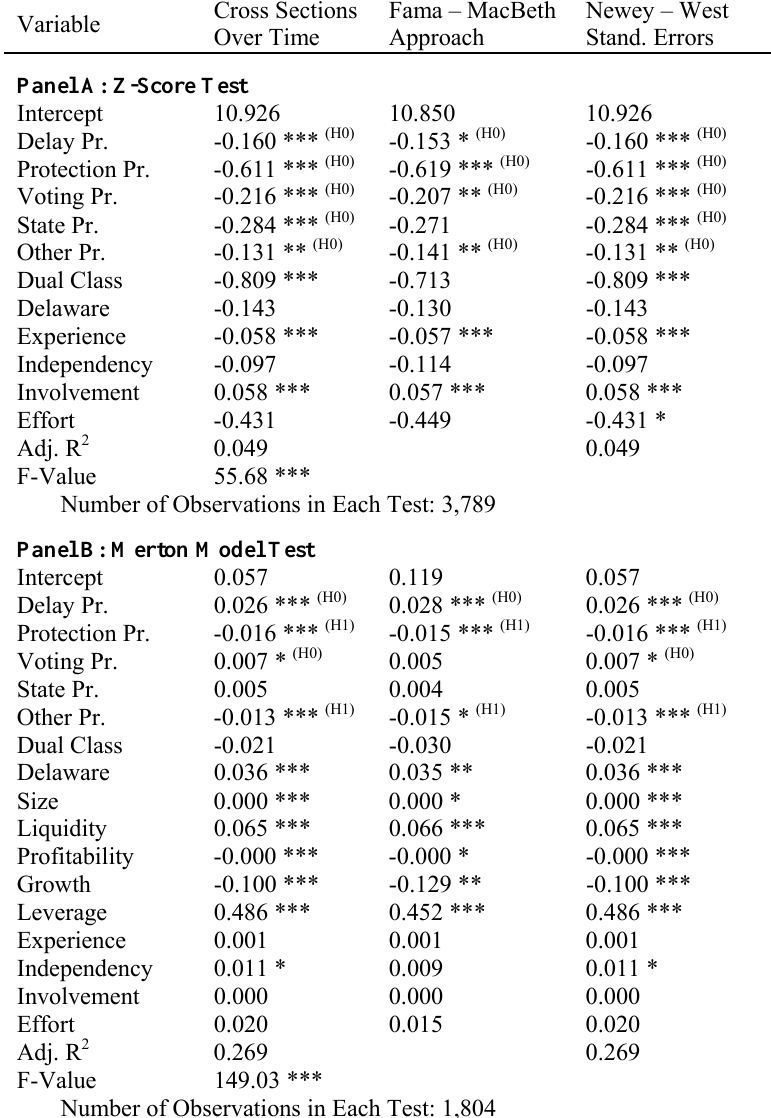
Table 4. Summary Results for the Corporate Governance Provisions